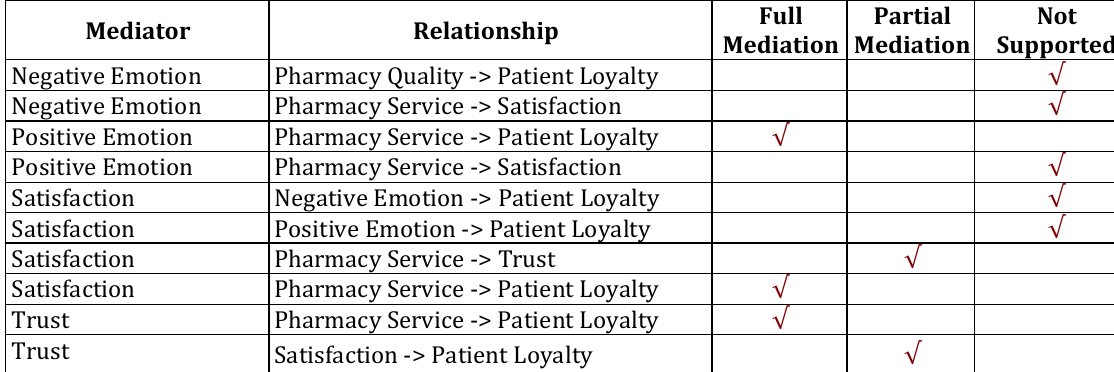
Table IV. The Mediation Role of Emotion, Satisfaction, and Trust Mediator